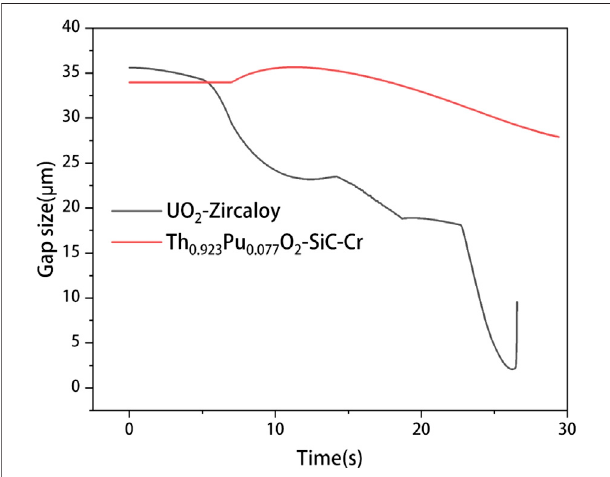
FIGURE 17 | Gap width evolution of UO 2 fuel with Zircaloy cladding and Th